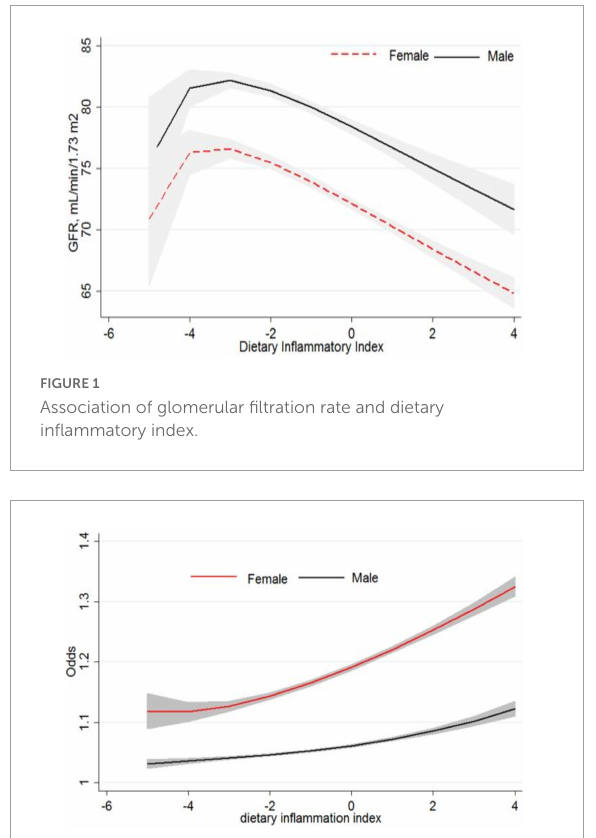
FIGURE2 Odds of chronic kidney disease and dietary inflammatory